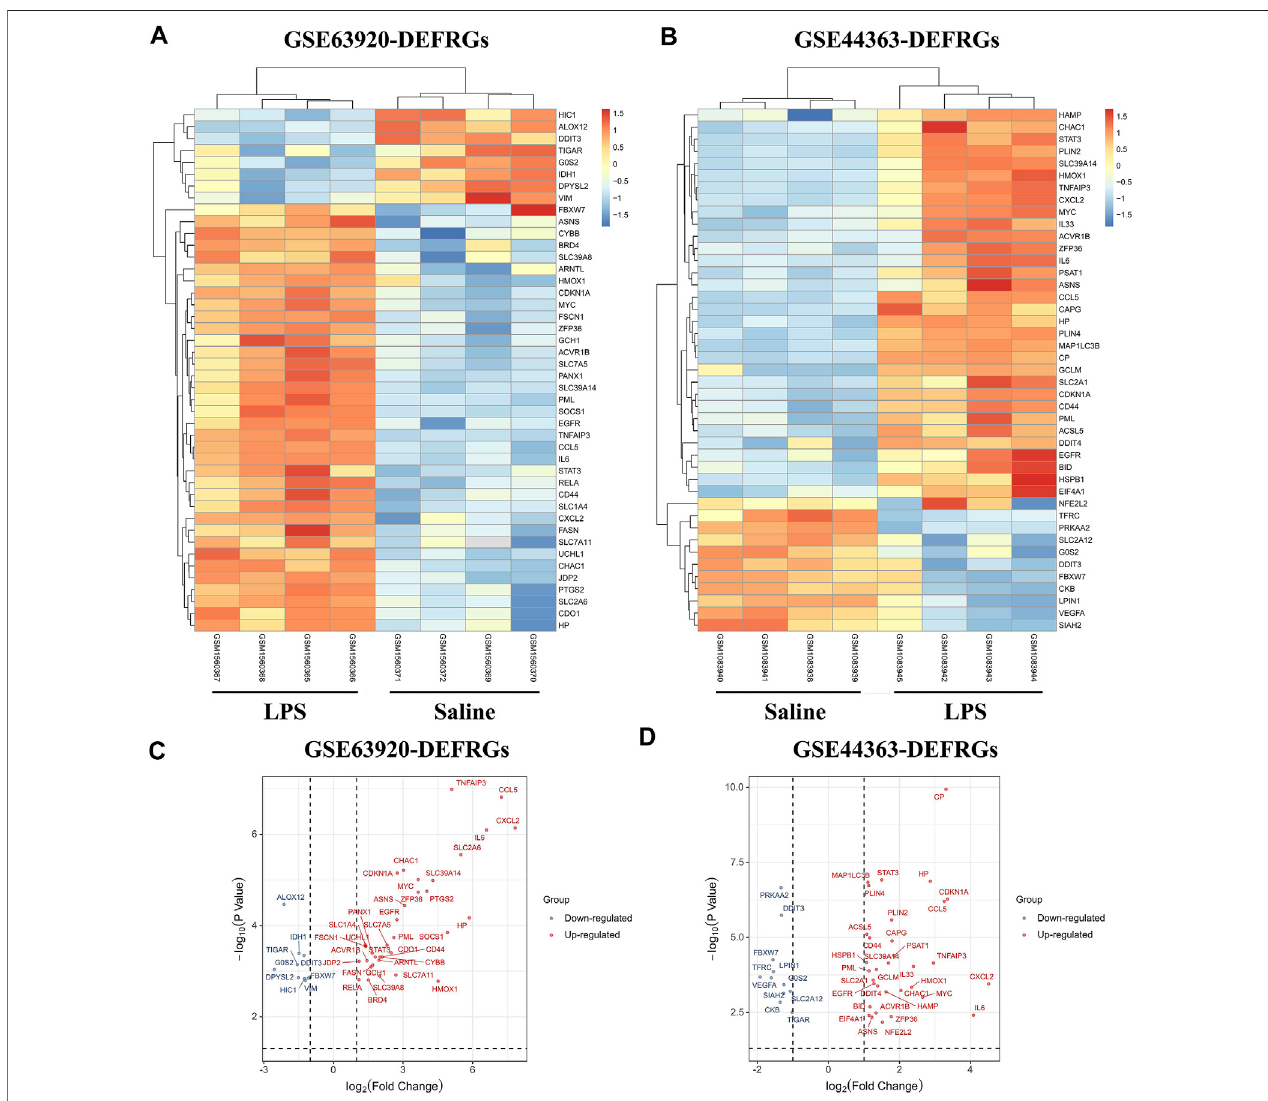
FIGURE2 | The heatmaps and volcanoplots ofDEFRGs. (A) The heatmap ofDEFRGs inGSE63920; (B) The heatmap of DEFRGs in GSE44363; (C) Thevolcano plot of DEFRGs in GSE63920; (D) The volcano plot of DEFRGs in GSE44363. FRGs, ferroptosis-related genes; DEFRGs, differentially expressed FRGs.